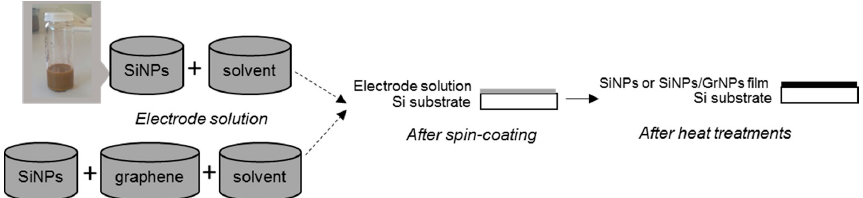
Figure 2. Schematic representation of SiNPs and SiNPs/GrNPs composites formation on 2D Si substrate.